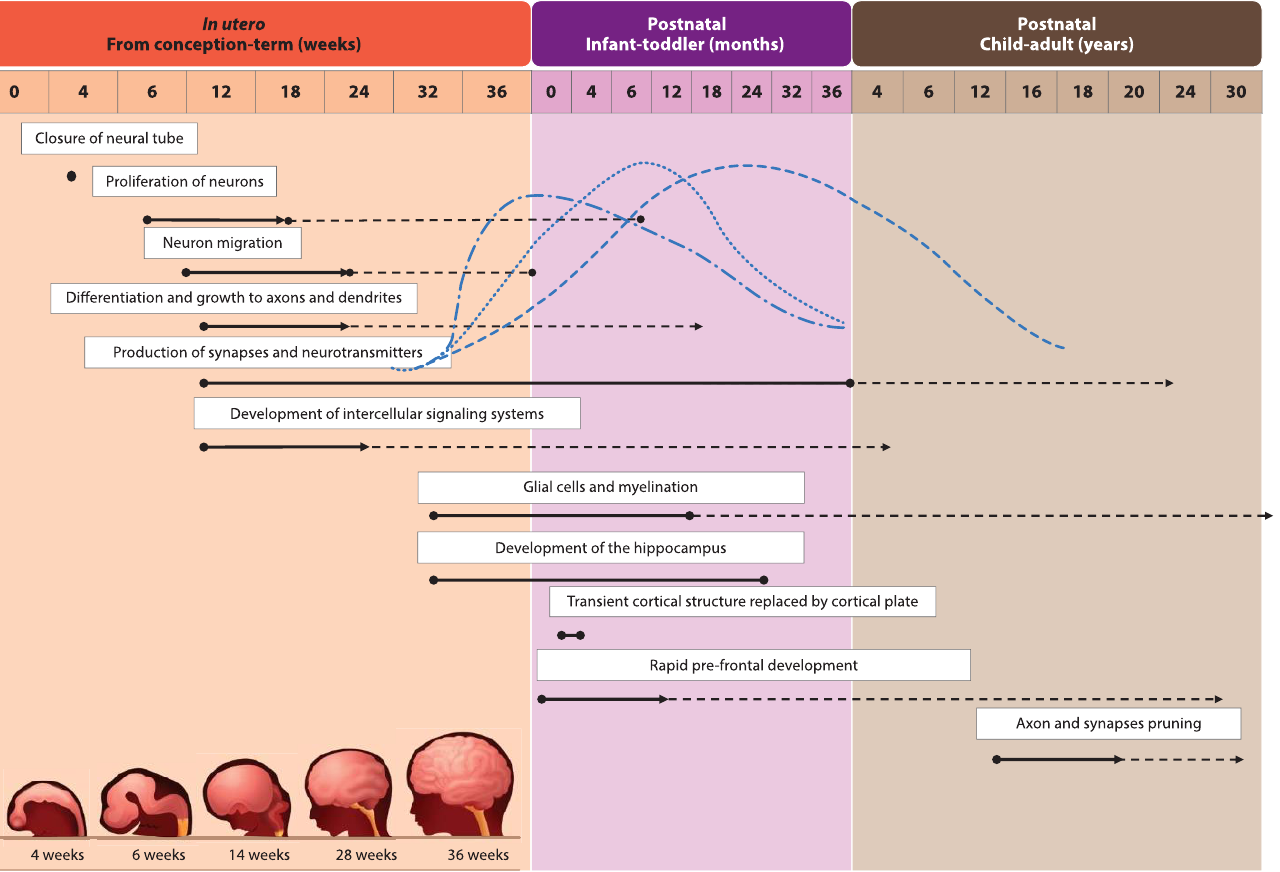
Depicts approximate timelines for experience-dependent synaptic development: Visual and auditory cortex (seeing/hearing); Angular gyrus/Broca’s area (language and speech); Prefrontal cortex (higher cognitive functions) Rapid development Prolonged development Figure 1. Visual representation of brain development timeline in humans from in utero up to adulthood.